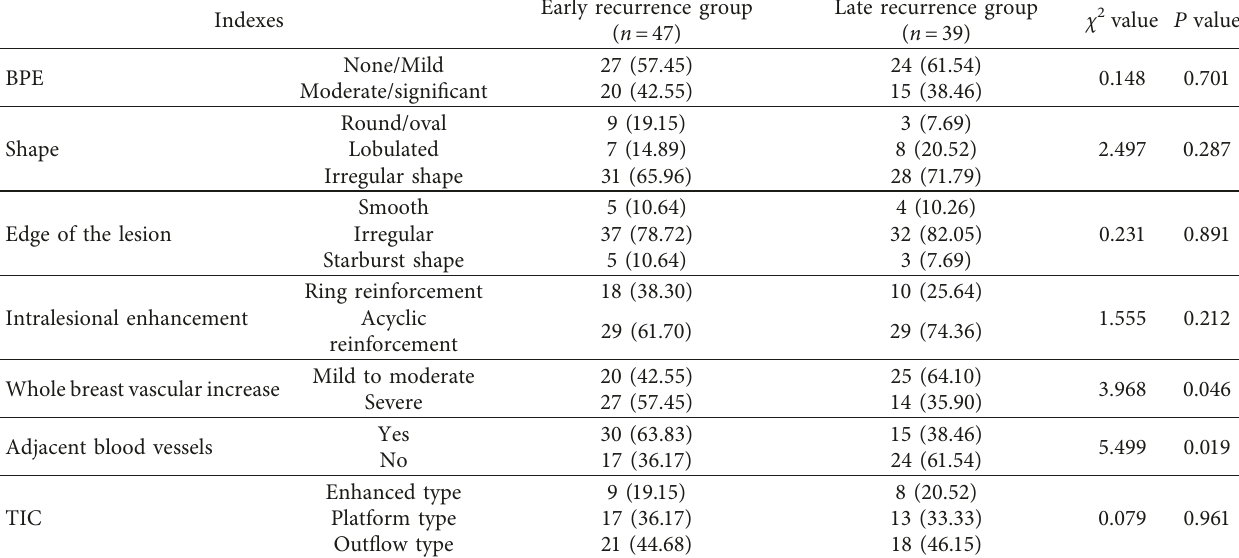
Table 1: Comparison of DCE-MRI features of breast cancer recurrence between two groups ( n ,